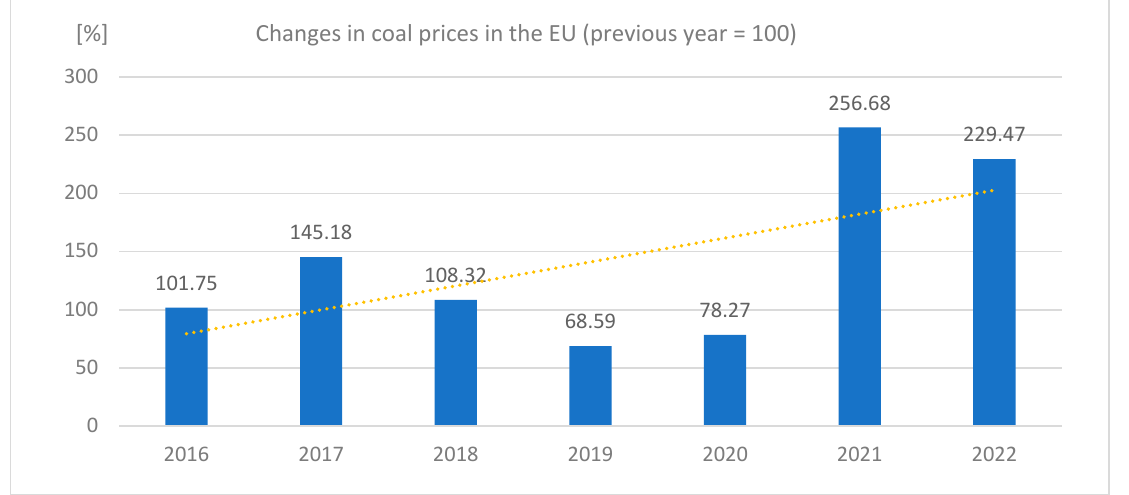
Figure 6. Changes in coal prices on the Rotterdam stock exchange between 2015 and 2022. Source: Authors’ original compilation based on [82].